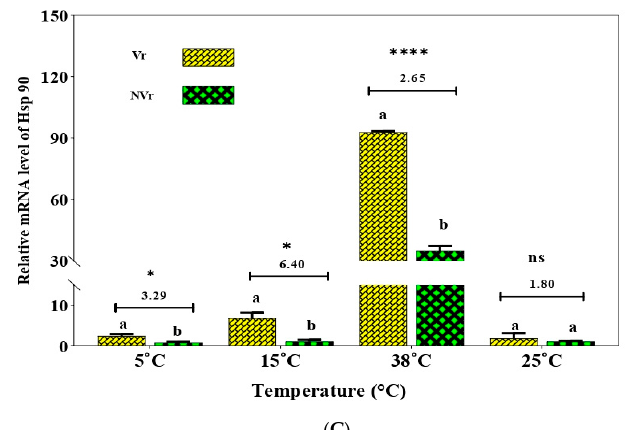
Figure 2. The differential expression of Hsp genes on exposure to different values of temperature stress (5 °C,15 °C, and 38 °C). ( A ) Hsp 40, ( B ) Hsp 70, and ( C ) Hsp 90.The bars represent the standard error of the mean (SEM), and the different letters above the symbols indicate a significant difference at 0.05 level; “ns” indicates that there is no significant difference between the two means at a given temperature; * indicates significant difference between the two means at a given temperature ( p < 0.05); ** indicates significant difference between the two means at a given temperature ( p < 0.01); *** indicates significant difference between the two means at a given temperature ( p < 0.001); **** indicates significant difference between the two means at a given temperature ( p < 0.0001).